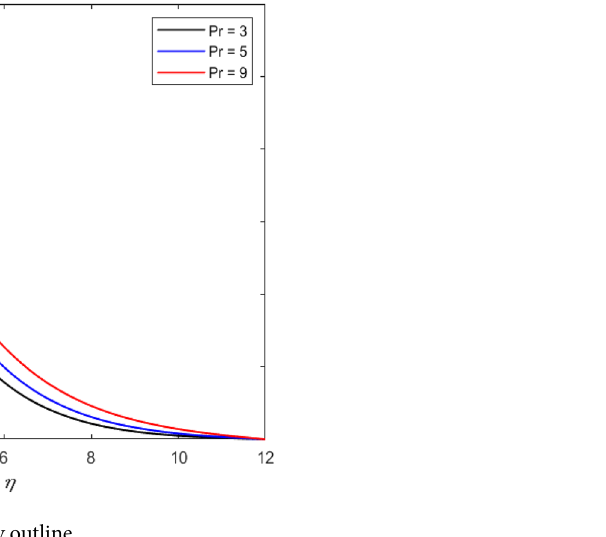
Figure 4. Effect of Pr on the velocity